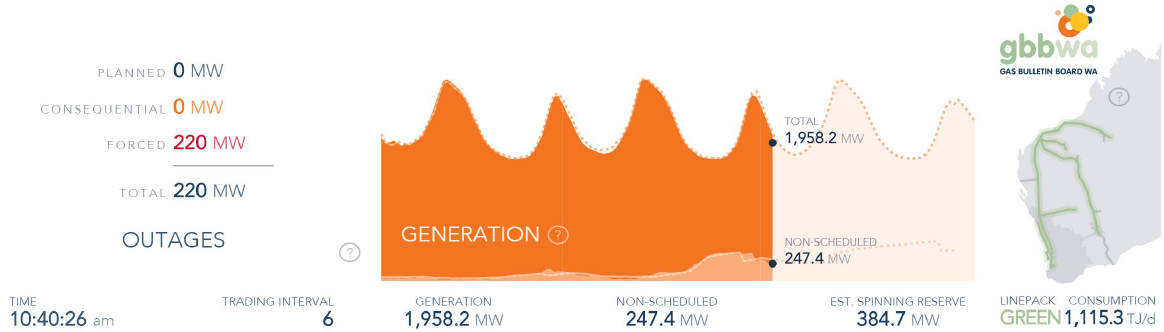
Figure 3. The dashboard for the wholesale electricity prices for Western Australia [33].